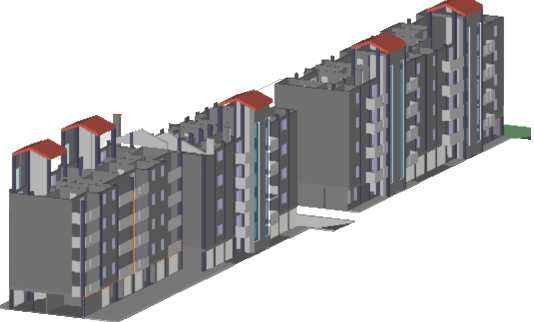
Figure 5. Savigliano.ifc BIM